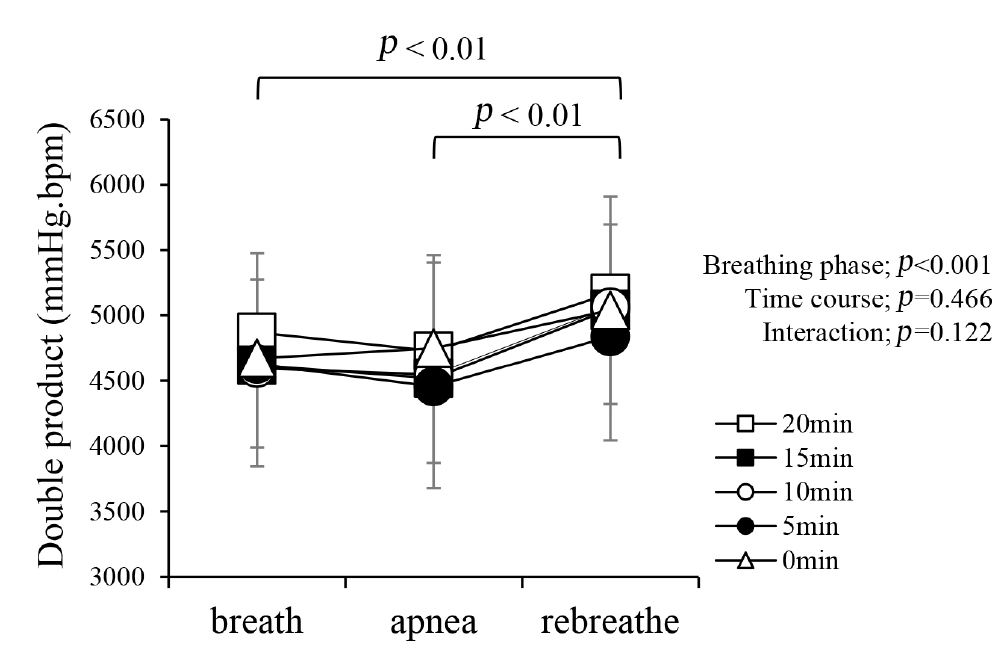
Fig. 4. Response of double product at the phase of breath, apnea, and rebreathe during intermittent apnea in 20 min. Double product multiplied aortic peripheral pressure by heart